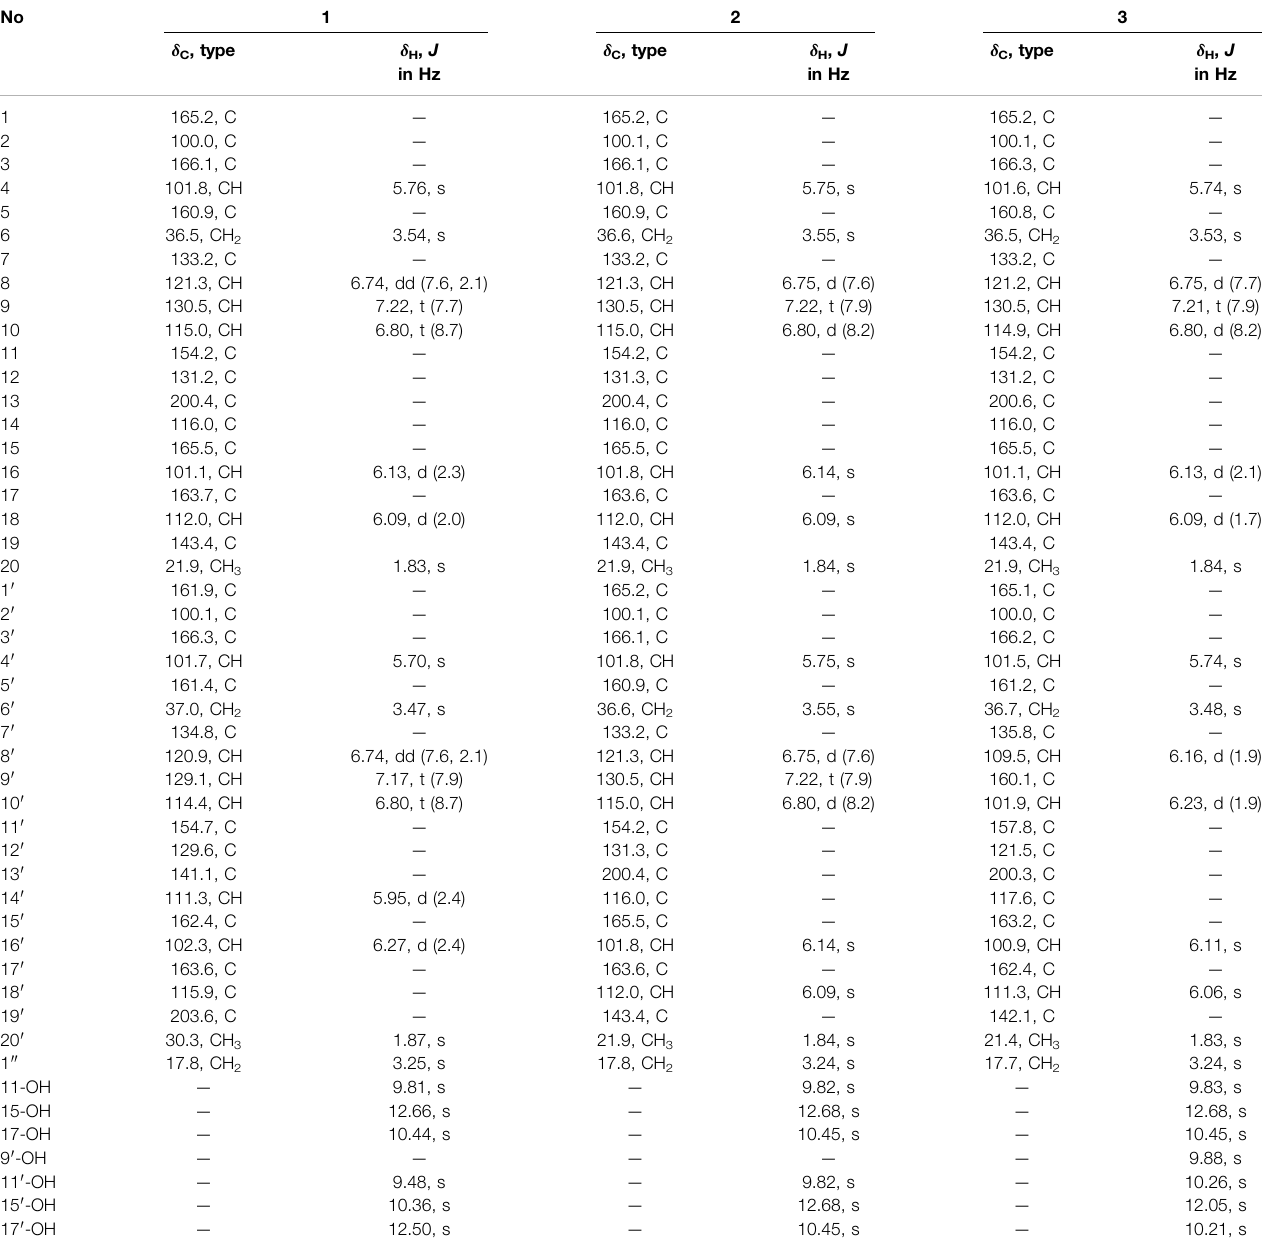
Table 1 ; (+)-ESI-MS: m/z 749.0 [M + H] + ; ( ‒ )-ESI-MS: